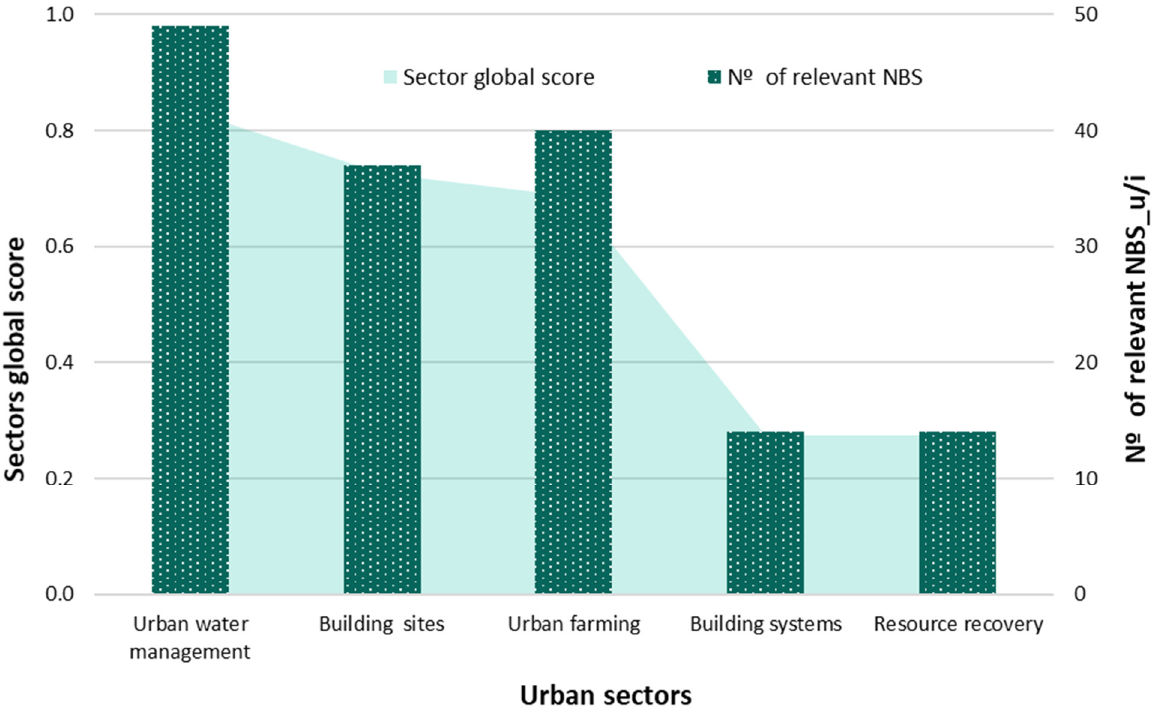
Figure 4. Global sector scores and number of relevant NBS units and interventions (NBS_u/i) for each sector. Global sector scores describe how many NBS_u/i were identified by each urban sector.